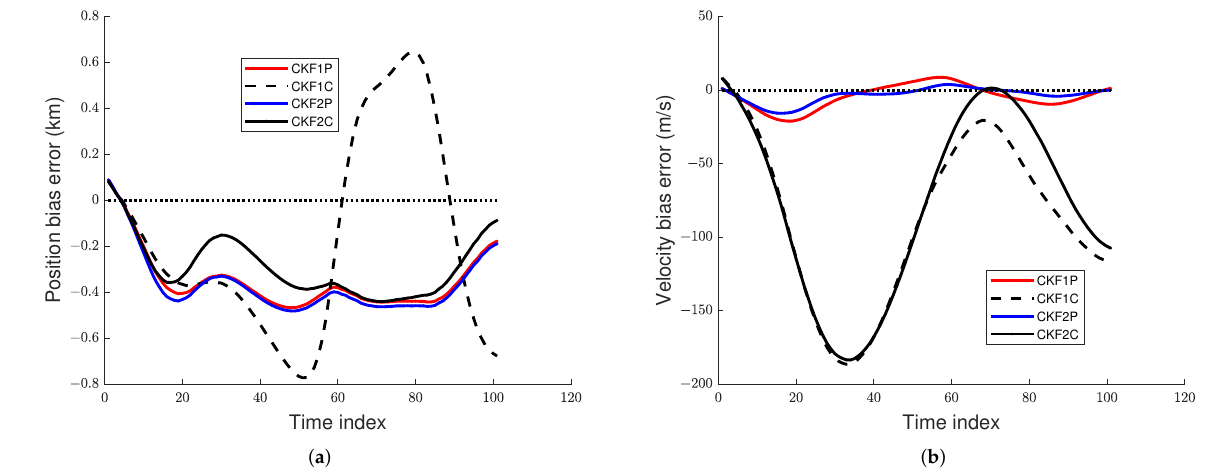
Figure 8. Position and velocity bias errors for the 1 mrad case. ( a ) Position bias, ( b ) Velocity bias.